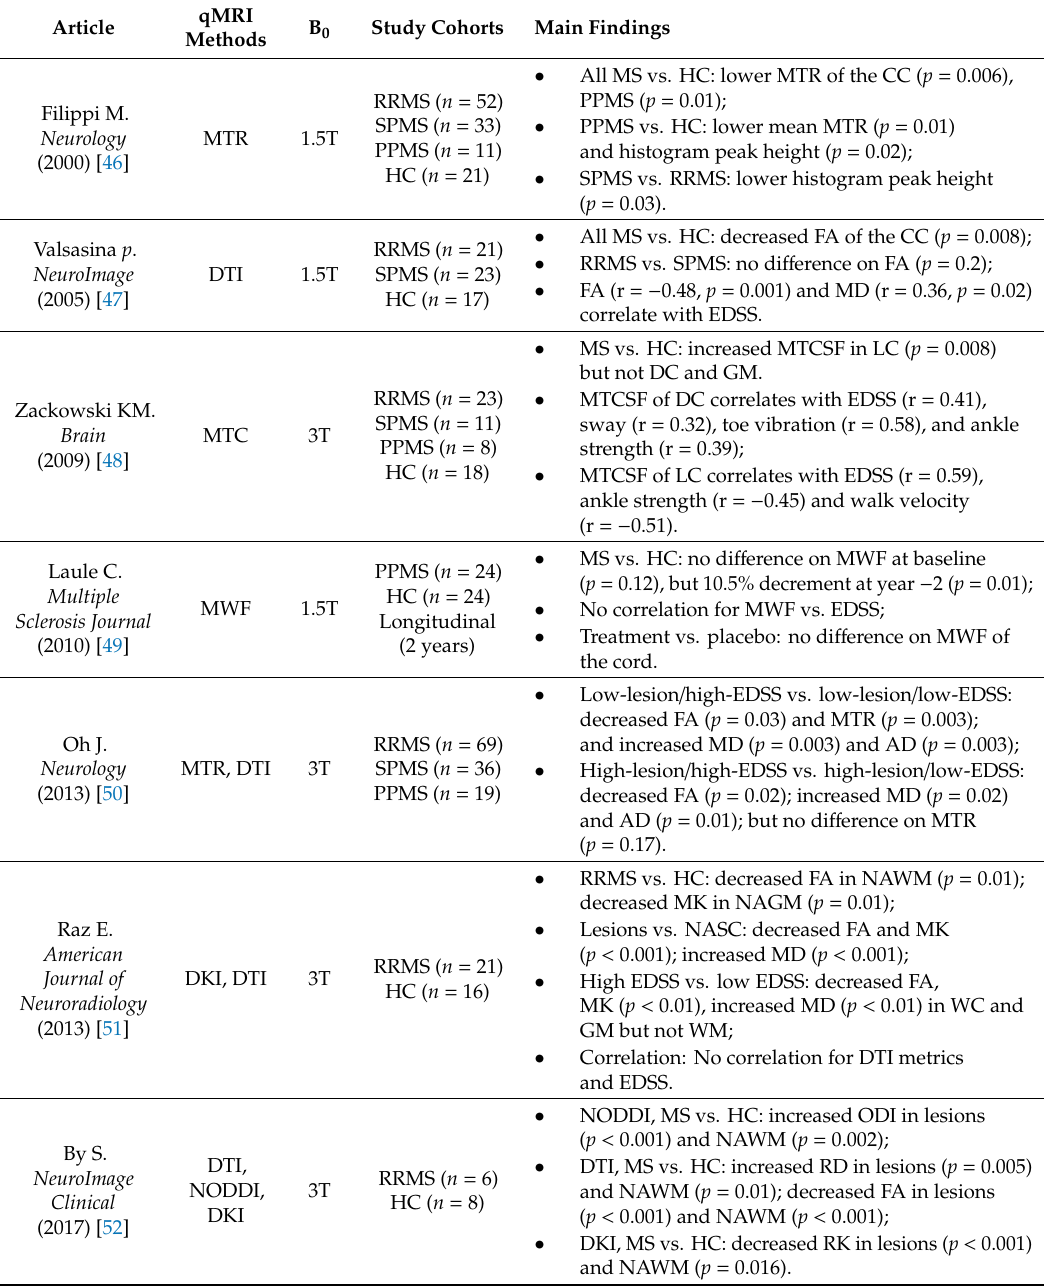
Table 1. Representative spinal cord quantitative MRI studies in patients with multiple sclerosis.